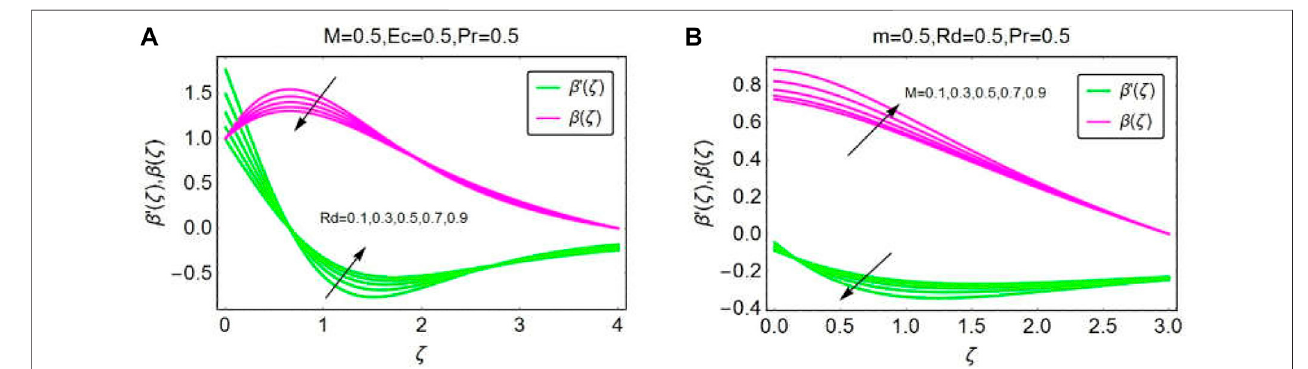
Frontiers in Physics |